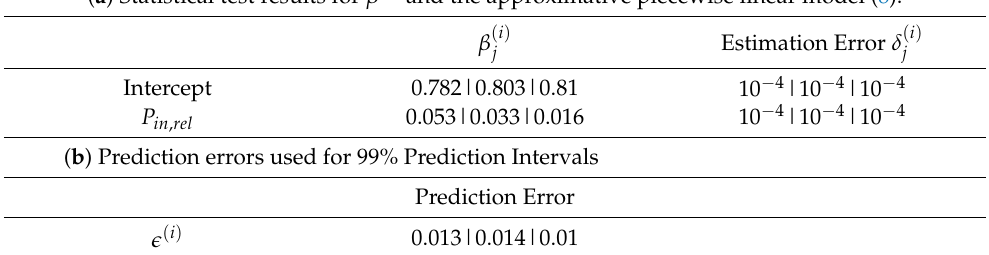
Table 6. Coefficient Estimation errors δ [ 0.1,0.334 ] | ( 0.334,0.668 ] | ( 0.668,1 ] . These errors are used for the 99% Coefficient Confidence Prediction